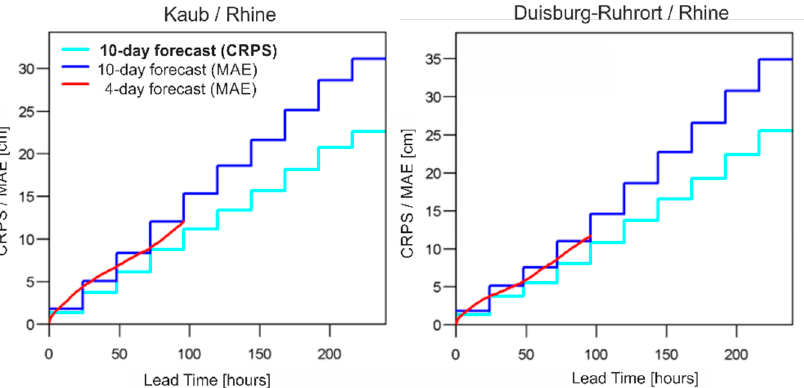
Figure 5. Verification of the 10-day forecast for 2 gauges at the River Rhine using the CRPS and the